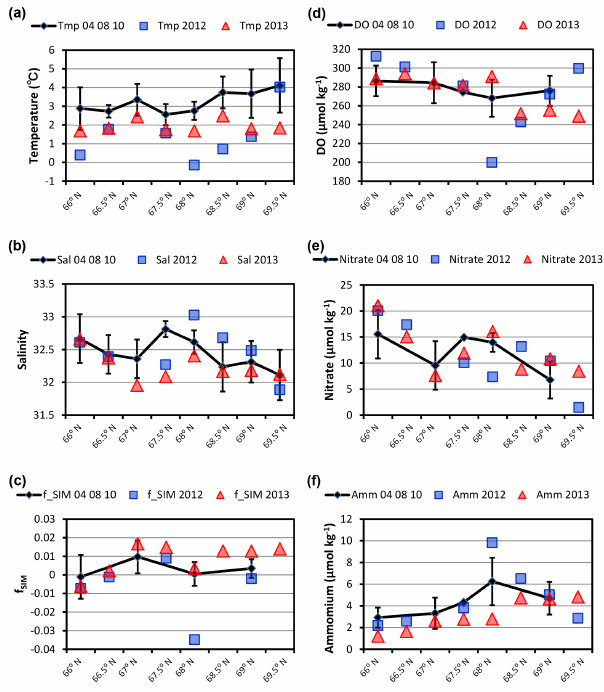
Figure 8. Plots of (a) temperature ( ◦ C), (b) salinity, (c) fraction of sea ice meltwater, (d) dissolved oxygen (µmolkg − 1 ) , (e) nitrate (µmolkg − 1 ) , and (f) ammonium (µmolkg − 1 ) at a depth of 40m along the 168 ◦ 45 (cid:48) W meridian near the US–Russia border with a 0.5 ◦ latitudinal interval. Line plots depict the mean values of late summer to autumn 2004, 2008, and 2010 R/V Mirai data with stan- dard error bars. Squares and triangles show the data obtained from the 13–17 September 2012 and 27 September–4 October 2013 R/V Mirai cruises,